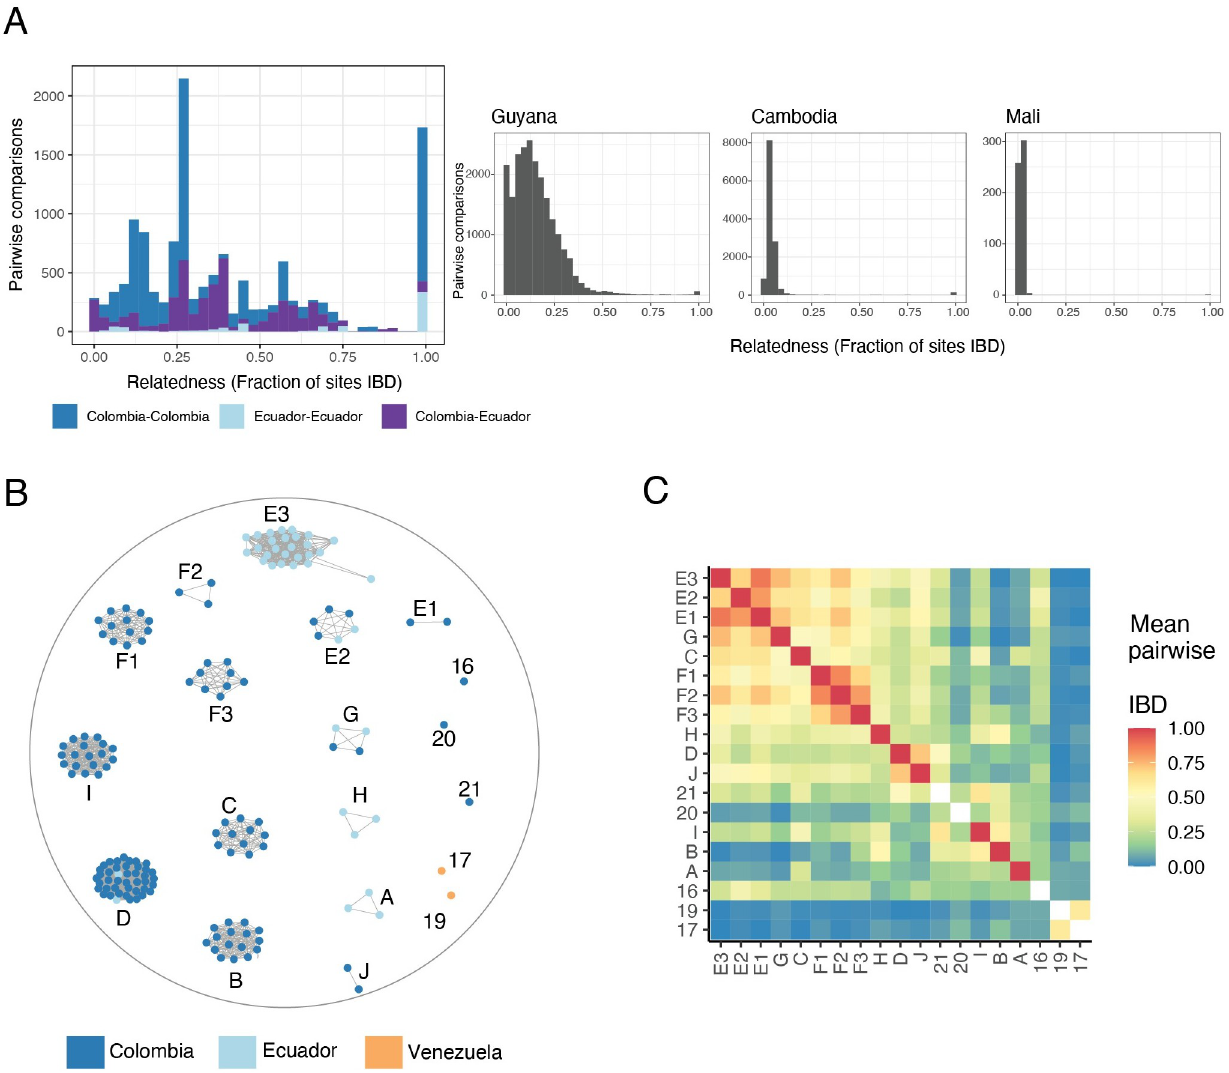
Fig 2. Relatedness between parasites along the Pacific Coast of Colombia and Ecuador. (A) Distribution of pairwise IBD in different transmission intensities: Pacific Coast of Colombia and Ecuador (2013–2017), Guyana [13], Cambodia [33] and Mali [33]. Samples from Western Cambodia belonging to the clonal expansion of K13 C580Y-harboring samples were excluded. (B) Network of 166 monoclonal samples collected from Colombia or Ecuador (2013–2017). Edges connecting nodes correspond to IBD � 0.99. (C) The mean IBD between clusters ranges from 0 to 0.89 and shows the presence of two larger “superclusters” at IBD > 0.8. Two Venezuelan samples (17 and 19), show low IBD with Colombian and Ecuadorian samples but intermediate IBD with each other. Single samples (numeric labels) are missing diagonal values as no intra-cluster comparisons could be